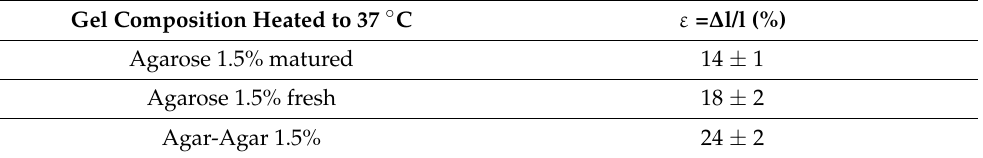
Table 1. Dependence-relative deformation on gel maturation.